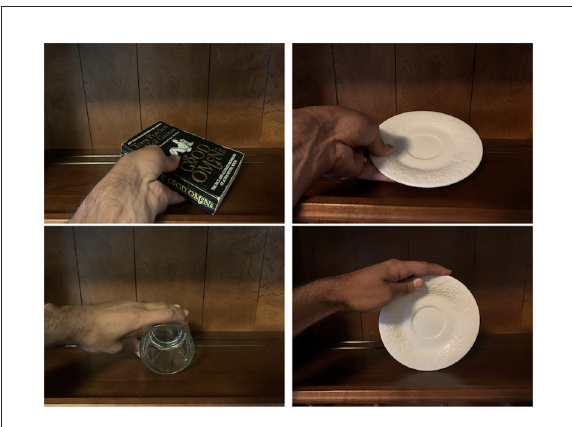
FIGURE5 Top: Grasping a book vs. grasping a plate. Bottom: Rolling a cup vs. rolling a plate. The “rolling” habitat places the objects in the same orientation, e.g., with the cup’s opening parallel to the